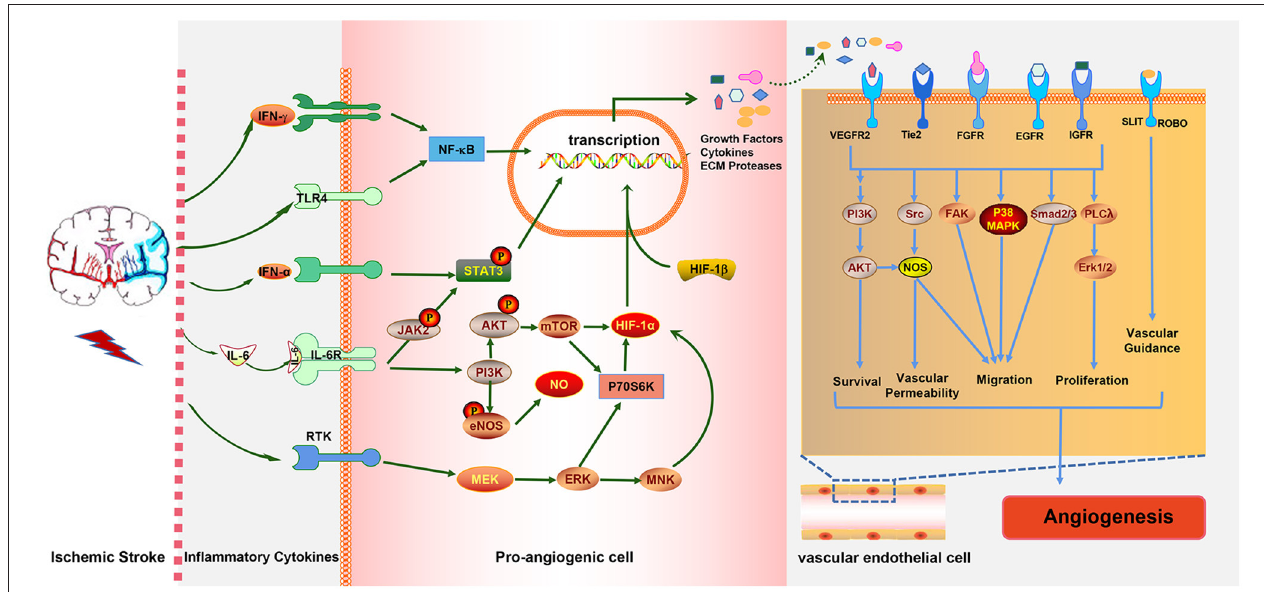
FIGURE 3 | The interaction between ischemic stroke, inflammatory cytokines, and inflammation-associated pathways. Ischemic stroke increases the expressions of the pro-inflammatory cytokines IFN- γ , IL-6 and IFN- α , which activate the NF- κ B, JAK2/STAT3, PI3K/AKT, and MAPK pathways in pro-angiogenic cells, leading to the elevated expressions of growth factors, cytokines, and extracellular matrix (ECM) proteases. These cytokines act on endothelial cells (ECs) to promote EC survival, vascular permeability, and migration proliferation and, ultimately, to promote angiogenesis, which in turn alleviates stroke injury.